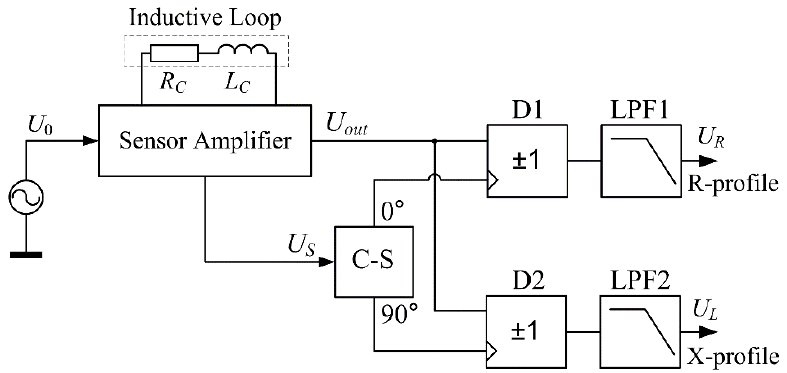
Figure 2. Block diagram of the conditioning system cooperating with the IL sensor comprised of a sensor amplifier (Figure 1), where: the C-S block provides two signals shifted by 90 degrees in relation to each other; D1, D2—synchronous demodulators; LPF1, LPF2—low-pass filters.